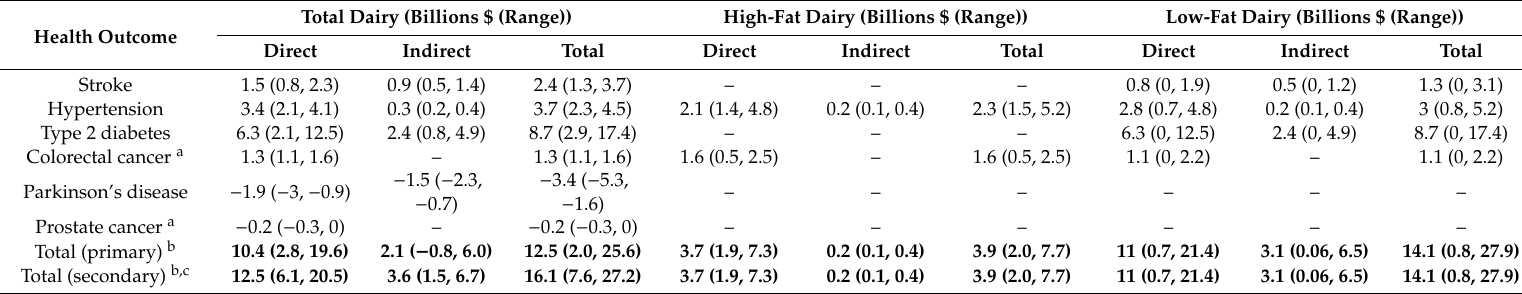
Table 5. Net annual change in health care costs (Billions $) associated with increasing total, high-fat, and low-fat dairy consumption to the Dietary Guidelines for Americans (DGA) recommendation of 3 cup-equivalents / day among adults in the United